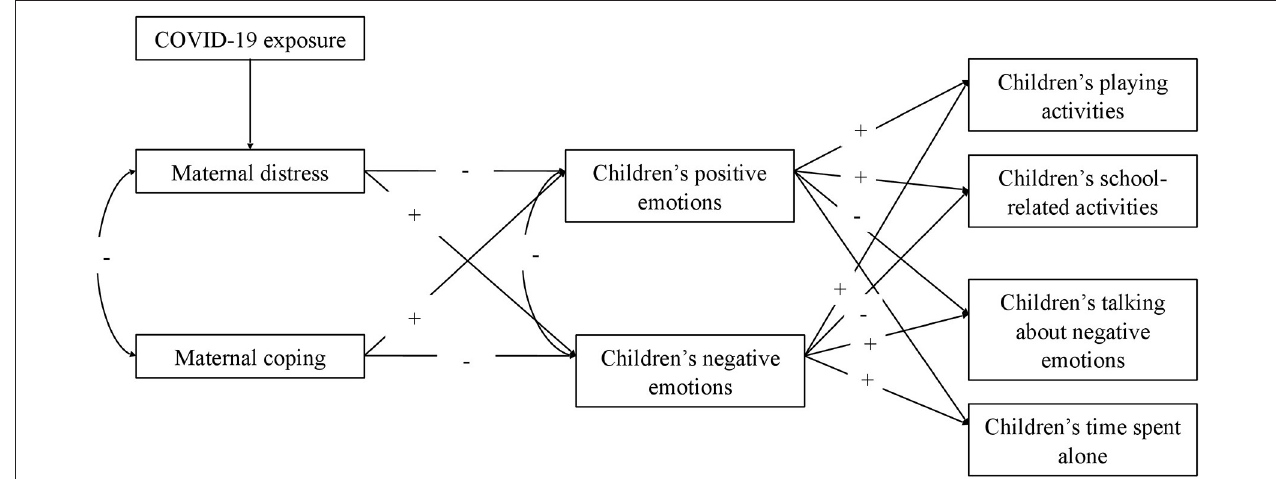
FIGURE 1 | The hypothesized